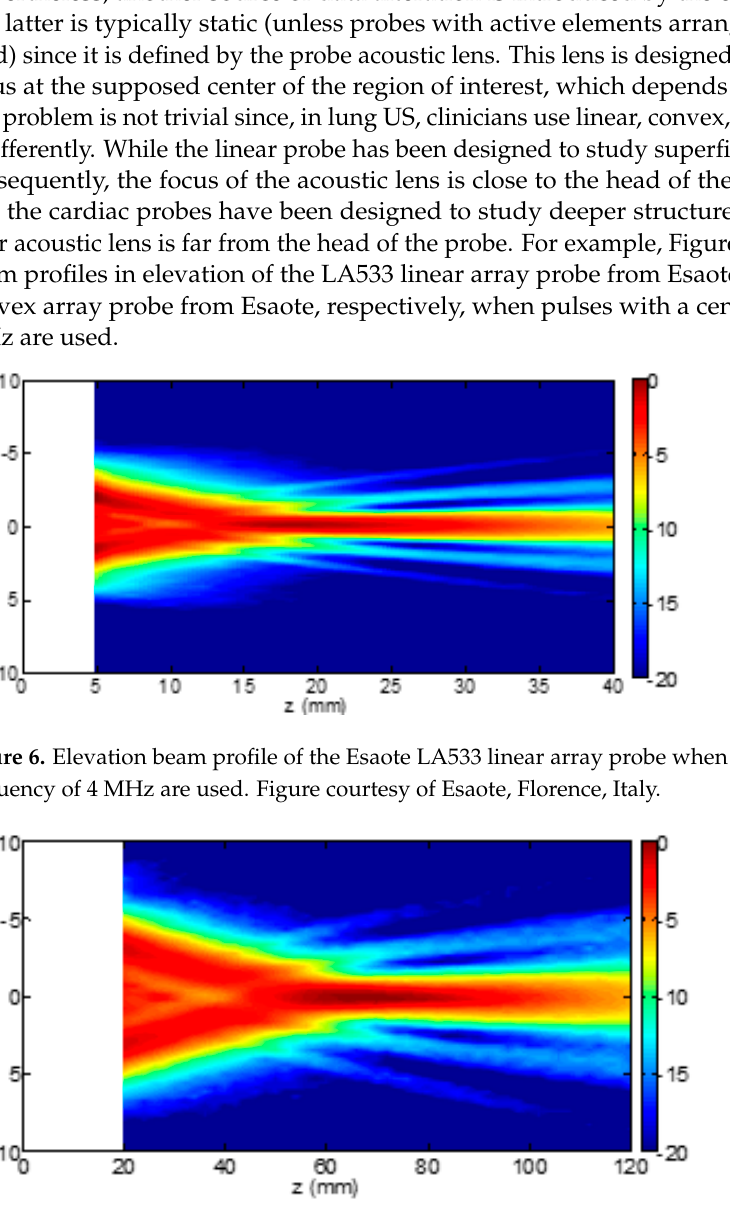
Figure 7. Elevation beam profile of the Esaote CA631 convex array probe when pulses with a central frequency of 4 MHz are used. Figure courtesy of Esaote, Florence, Italy.